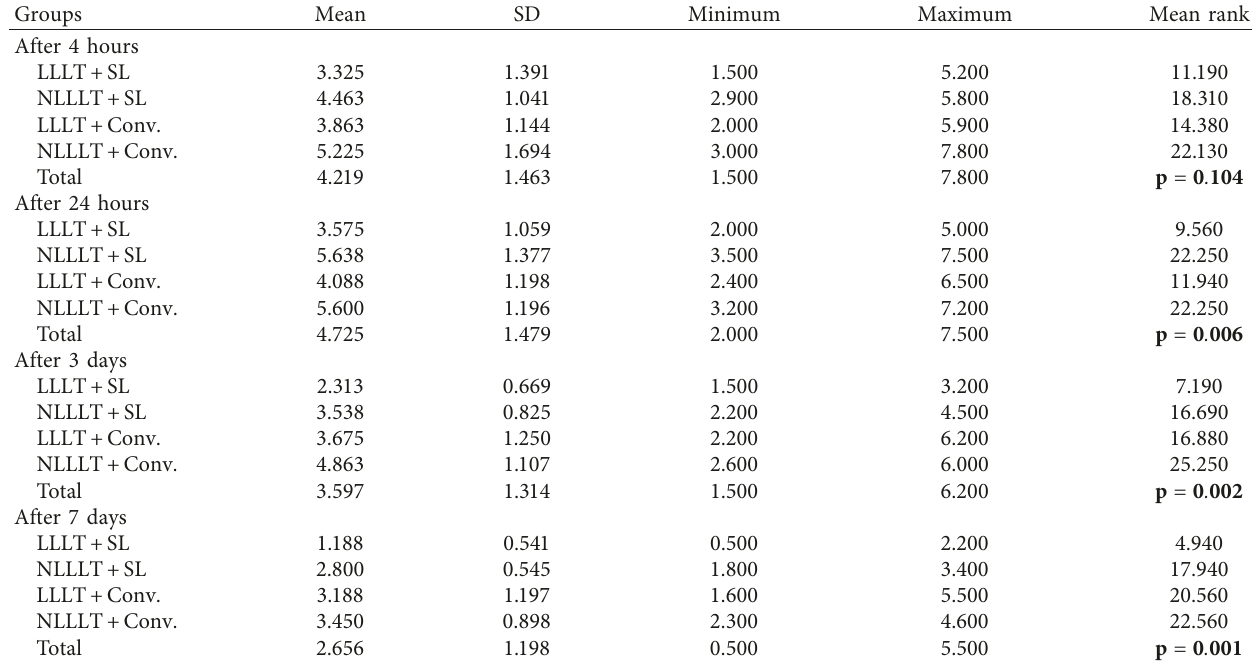
Table 2: Kruskal–Wallis H Test comparison among all groups.